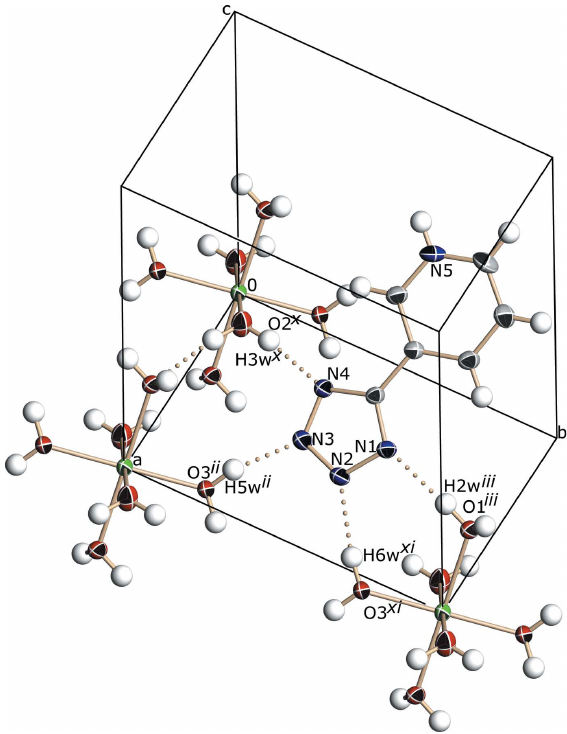
Figure 1 The molecular structure of the asymmetric unit (plus the three water molecules of the hexaaquazinc cation generated by symmetry), showing the atom labelling and displacement ellipsoids drawn at the 50% probability level. [Symmetry code: (i) (cid:3) x , 2 (cid:3) y , 2 (cid:3) z .]